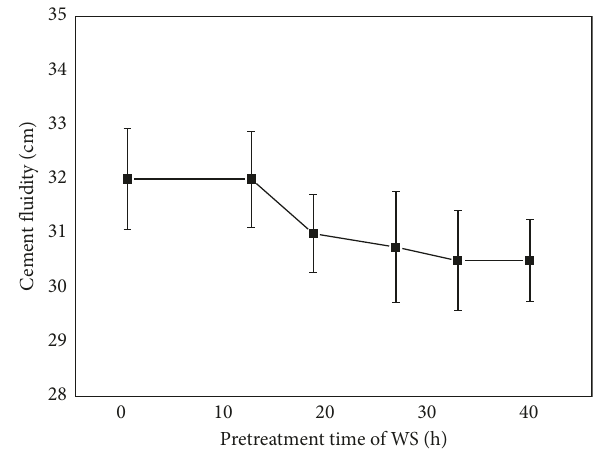
Figure 2: Effect of different pretreatment time periods of wheat straw (WS) on cement